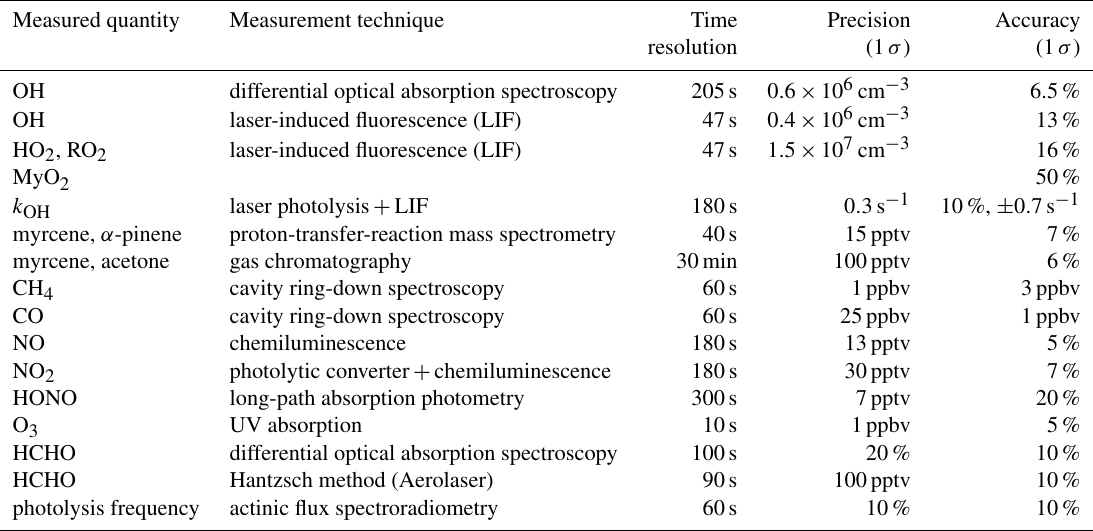
Table 2. Instrumentation for radical and trace gas detection in the experiments. Measured